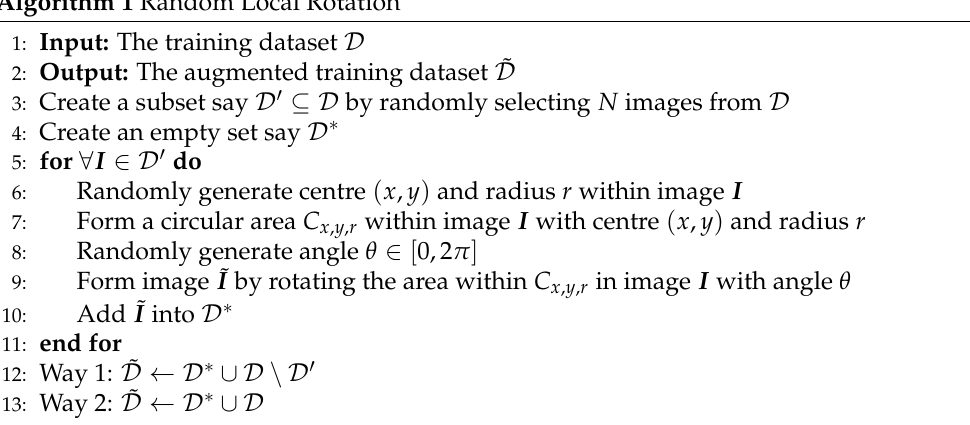
Figure 14. The proposed random local rotation data augmentation strategy. Symbol (cid:12) represents pointwise multiplication. Algorithm 1 Random Local